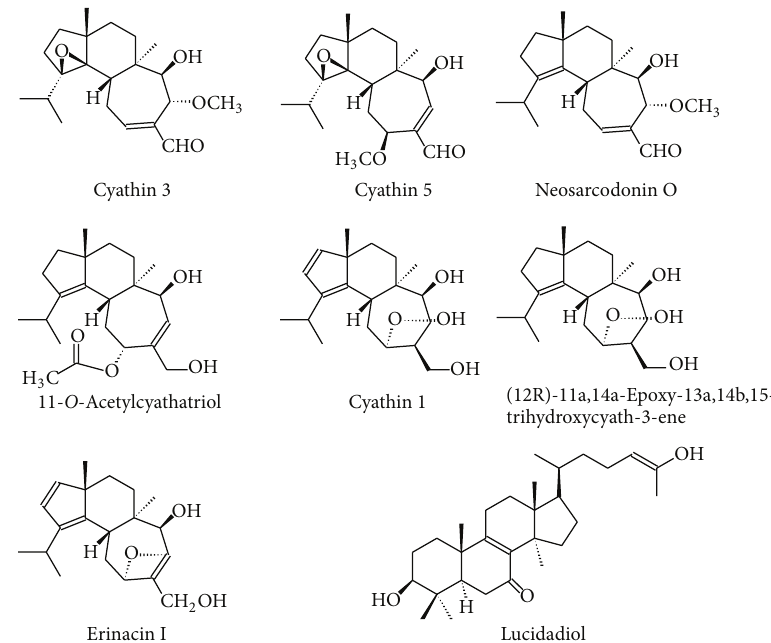
Figure 2: Examples of some terpenoid bioactive compounds isolated from edible